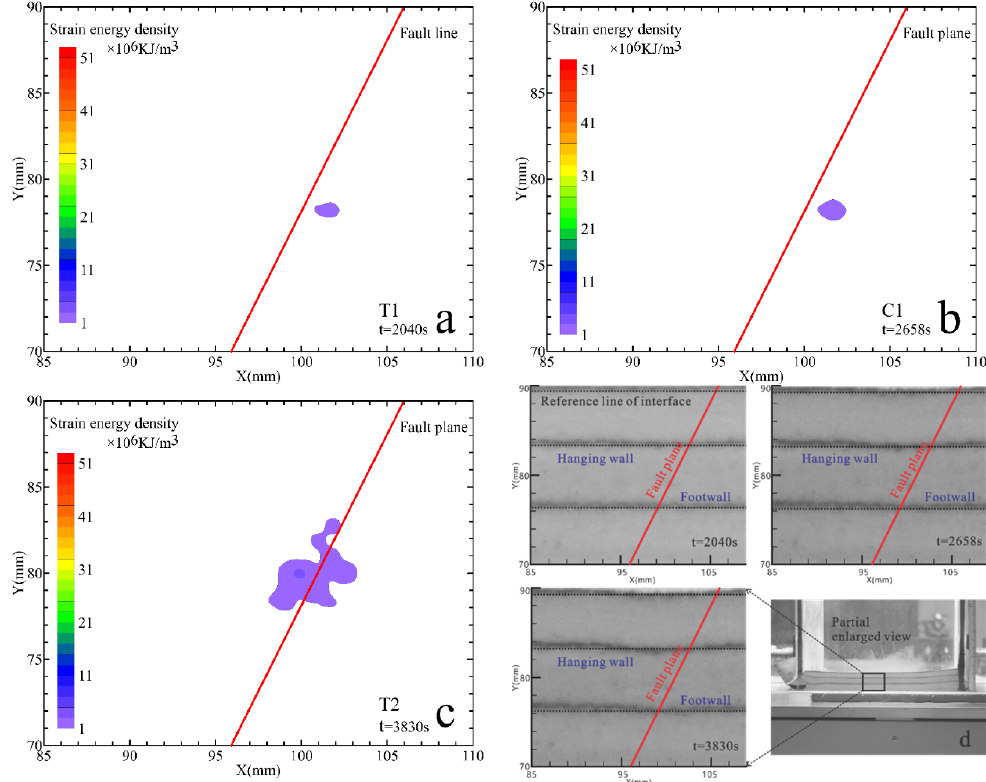
Figure 12. Strain energy density distribution at ( a ) T1, t = 2040 s; ( b ) C1, t = 2658 s; ( c ) T2, t = 3830 s. ( d ) the normal fault evolution observed from the simulation chamber. C refers to the time point between key periods.